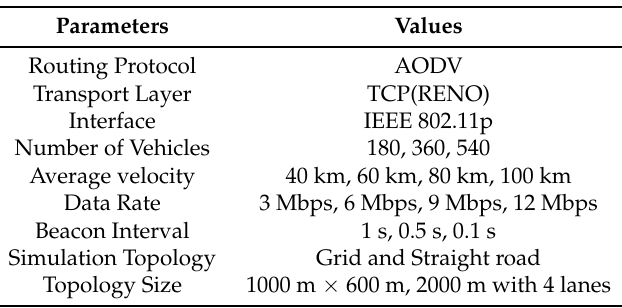
Table 1. Simulation